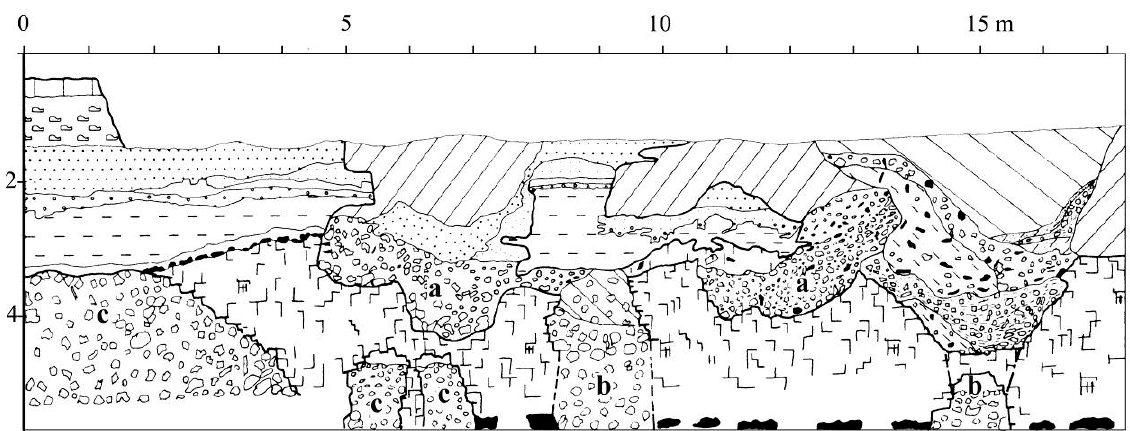
Figure 12. Spiennes. Extraction pits on the edge of the Petit-Spiennes plateau (Hubert 1976b): a. pits; b. shafts; c. galleries. Graphics by A. Hauzeur.